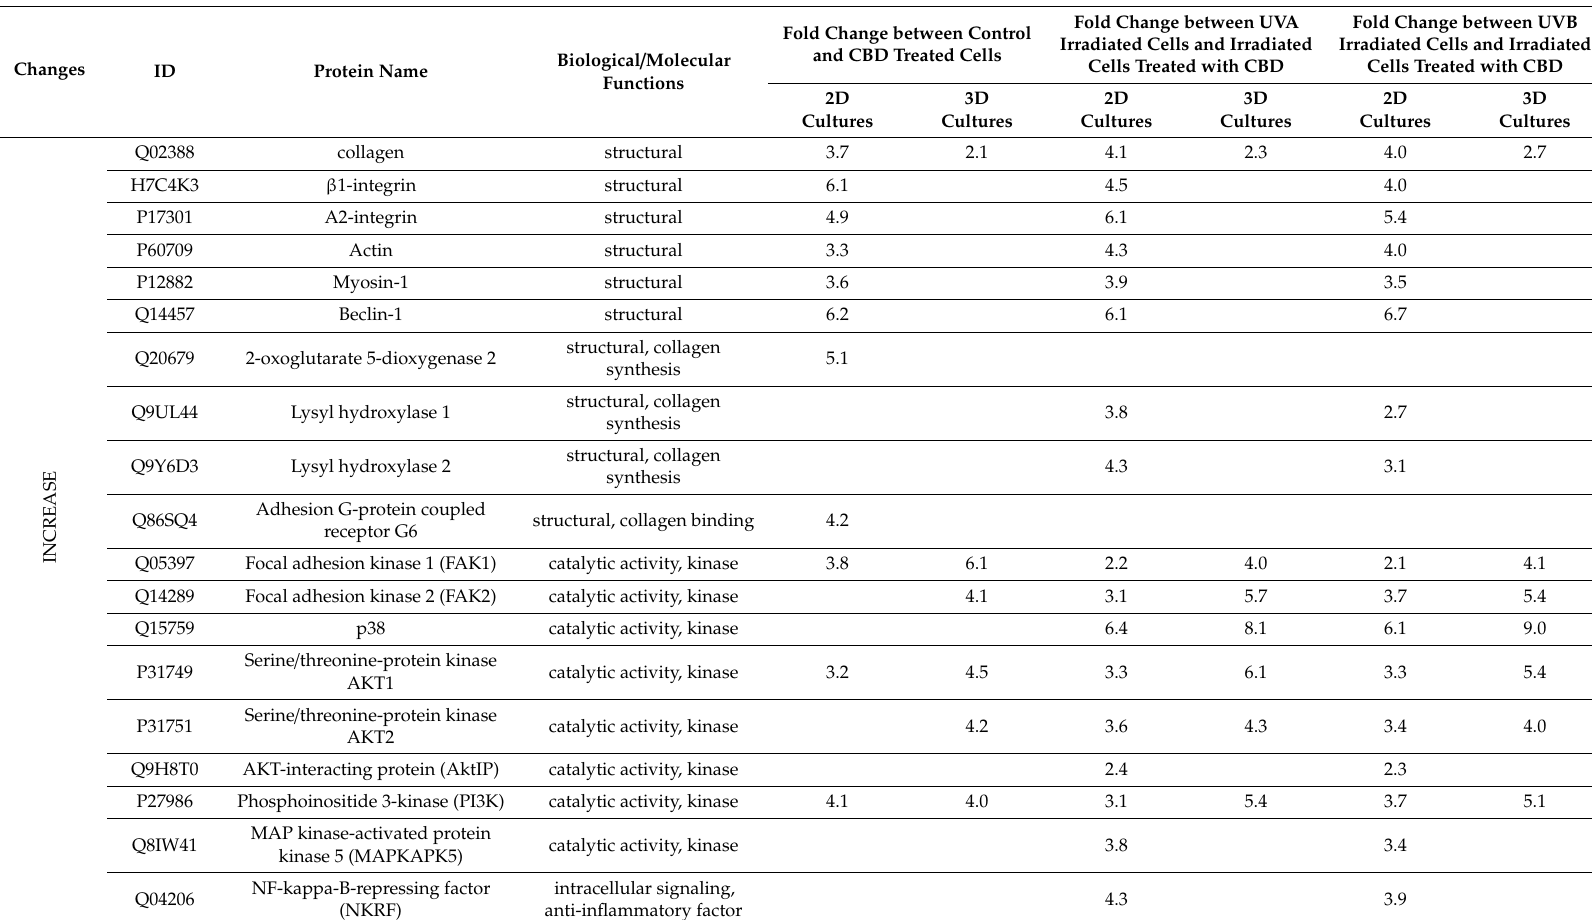
Table 1. The list and biological / molecular functions of proteins that expression was significant changed in fibroblasts irradiated with UVA (20 J / cm 2 ) and UVB (200 mJ / cm 2 ) or / and treated with cannabidiol (CBD, 4 µ M) in two-dimensional (2D) or three-dimensional (3D) culture model.